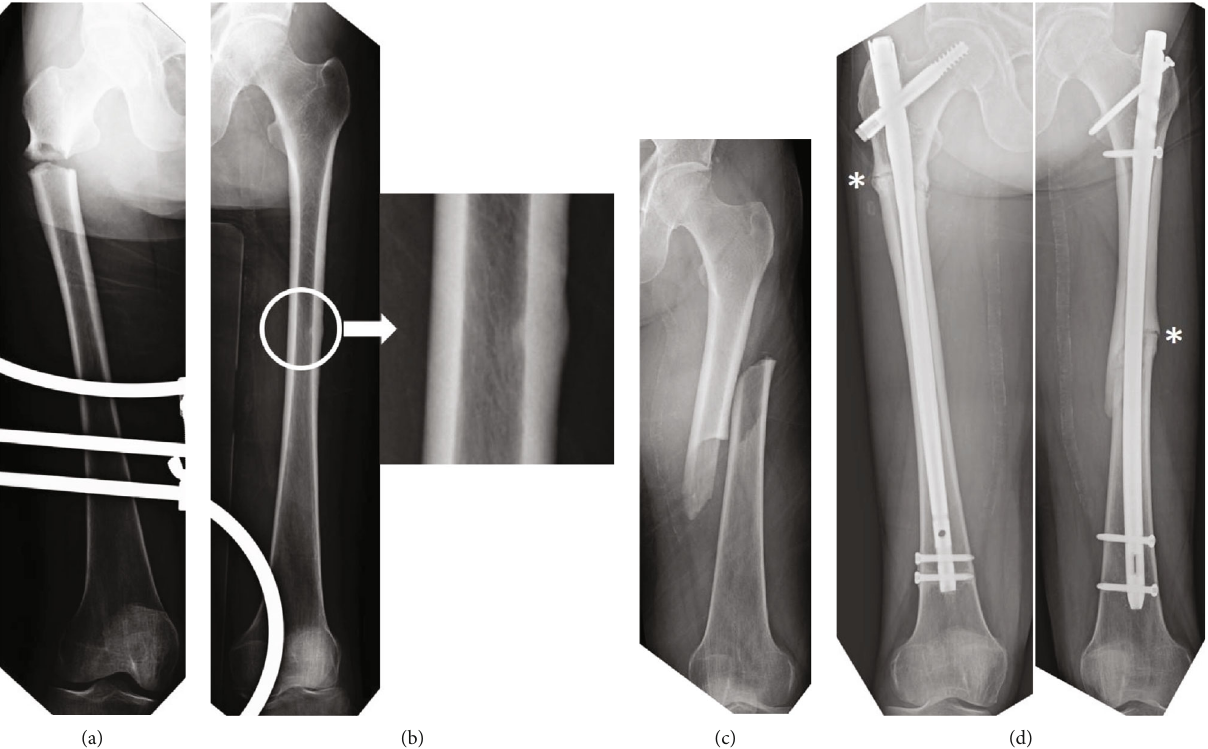
Figure 1: (a) The patient su ff ered a subtrochanteric AFF without prodromal pain on the right side as a result of a fall. (b) At that time, the left femoral roentgenogram showed periosteal and endosteal thickening of the lateral cortex at the diaphysis (circle; see magni fi cation). (c) Fifteen months later, the patient su ff ered a diaphyseal AFF on the left side by falling without prodromal pain. (d) A small gap at the lateral cortex of fracture site (asterisk) remained on the right and left sides at 29 and 14 months after the surgery,